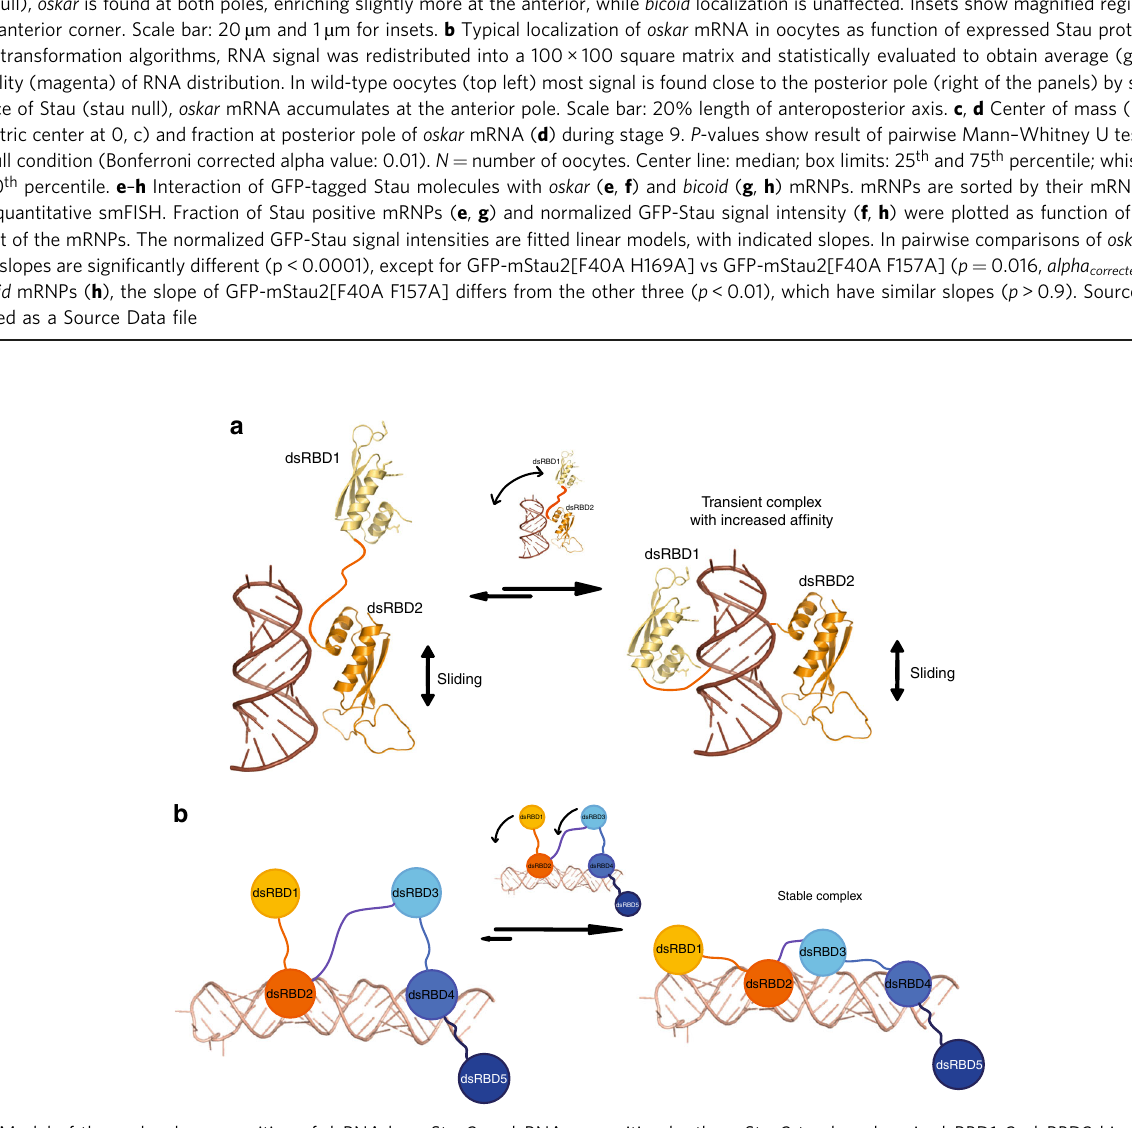
Fig. 7 Model of the molecular recognition of dsRNA by mStau2. a dsRNA recognition by the mStau2 tandem domain dsRBD1 – 2. dsRBD2 binds dsRNA promiscuously with moderate af fi nity and slides along the stem. Through this sliding, dsRBD2 positions dsRBD1 close to the dsRNA. When a suitable dsRNA structure is reached, dsRBD1 also binds, thereby strongly increasing the af fi nity of the tandem domain to dsRNA. b Next to the tandem domain dsRBD 1 – 2, dsRBD 3 – 4 acts in a similar way. Here, dsRBD4 does the fi rst promiscuous binding with moderate af fi nity. When dsRBD2 and dsRBD4 position dsRBD1 and dsRBD3, respectively, close to a suitable dsRNA, the respective domains also bind the dsRNA, thereby increasing af fi nity. Only when suitable dsRNA binding sites for both tandem domains are in suf fi cient spatial proximity can all four dsRBDs be bound and form a stable complex with the RNA target